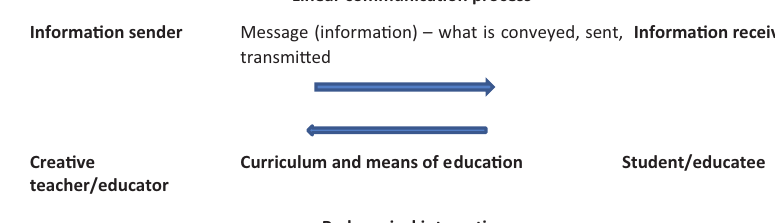
Figure 1. The relationship between the processes of communication and education in the educational process (source: created by